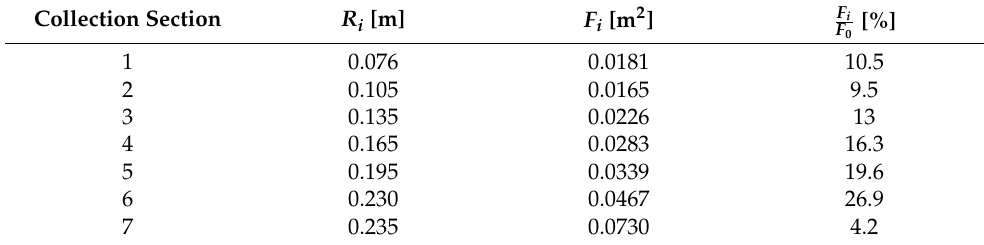
Table 1. Dimensions of the collection sections of the liquid collection